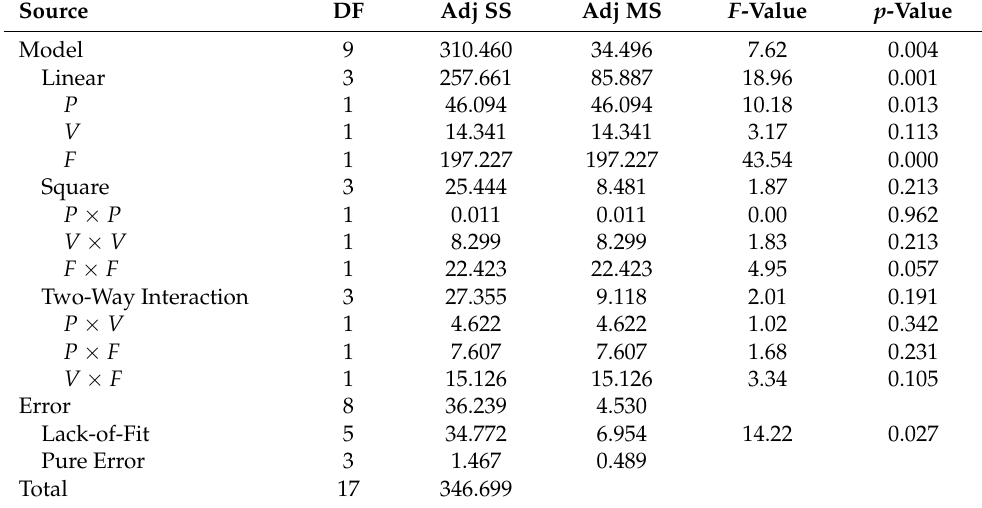
Table 6. ANOVA analysis of dilution.